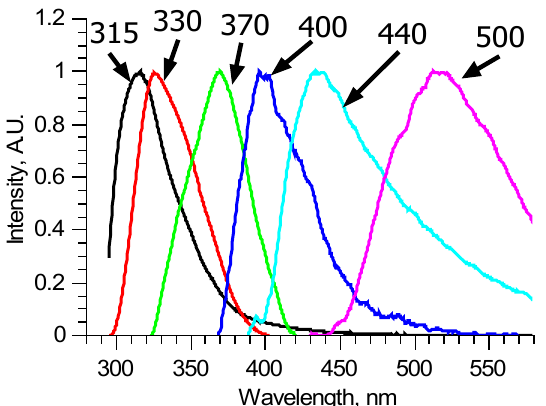
Figure 5. Reconstructed fluorescence spectra of pure components named by their peak wave- lengths.